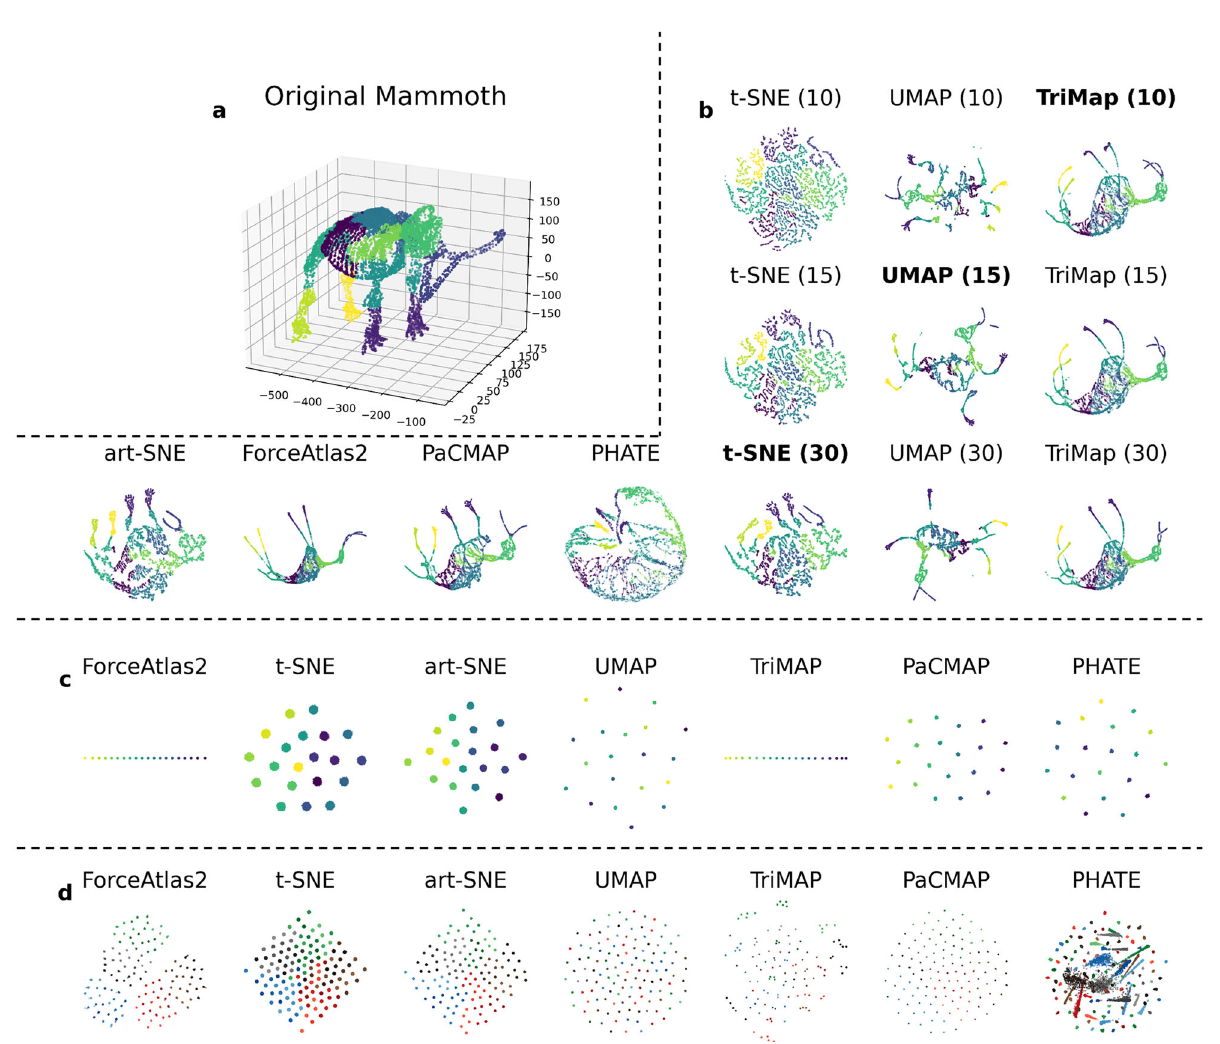
Fig. 4 Qualitative evaluation of global structure preservation using the Mammoth dataset, the Gaussian Linear dataset, and the Gaussian Hierarchical dataset. a Visualization of the original Mammoth dataset. b DR results on the Mammoth dataset. Results of art-SNE, ForceAtlas2, PaCMAP and PHATE are created under default con fi gurations (these algorithms automate their own parameter tuning), and results of DR algorithms t-SNE, UMAP, and TriMap are created under different parameter con fi gurations. We tune the most important parameter that controls the visual presentation of the fi gure, which is perplexity for t-SNE, n_neighbors for UMAP and n_inliers for TriMap, with the parameter speci fi ed in the brackets. All DR algorithms preserve local structure well, while only TriMap, PaCMAP, and ForceAtlas2 preserve global structure well. c Results of DR algorithms on the Gaussian Linear dataset. Sample points are annotated in gradient color, demonstrating their relative location in the high dimensional space. Although t-SNE, PHATE and UMAP successfully preserve the local structure, the global structure is completely lost and the gradual change of color observed in other visualizations is not observed. d Results of DR algorithms on the Hierarchical Gaussian dataset. The Hierarchical Gaussian dataset is particularly dif fi cult, because it contains structure at multiple scales that needs to be preserved. Here the points are colored by their meso-level cluster assignment (see de fi nition in Supplementary Note 7.1). t-SNE, UMAP and TriMap do not perform well, since micro clusters from the same meso clusters are not placed together, whereas art-SNE and PacMAP perform better and ForceAtlas2 performs quite well. PHATE fails to preserve local structure on this